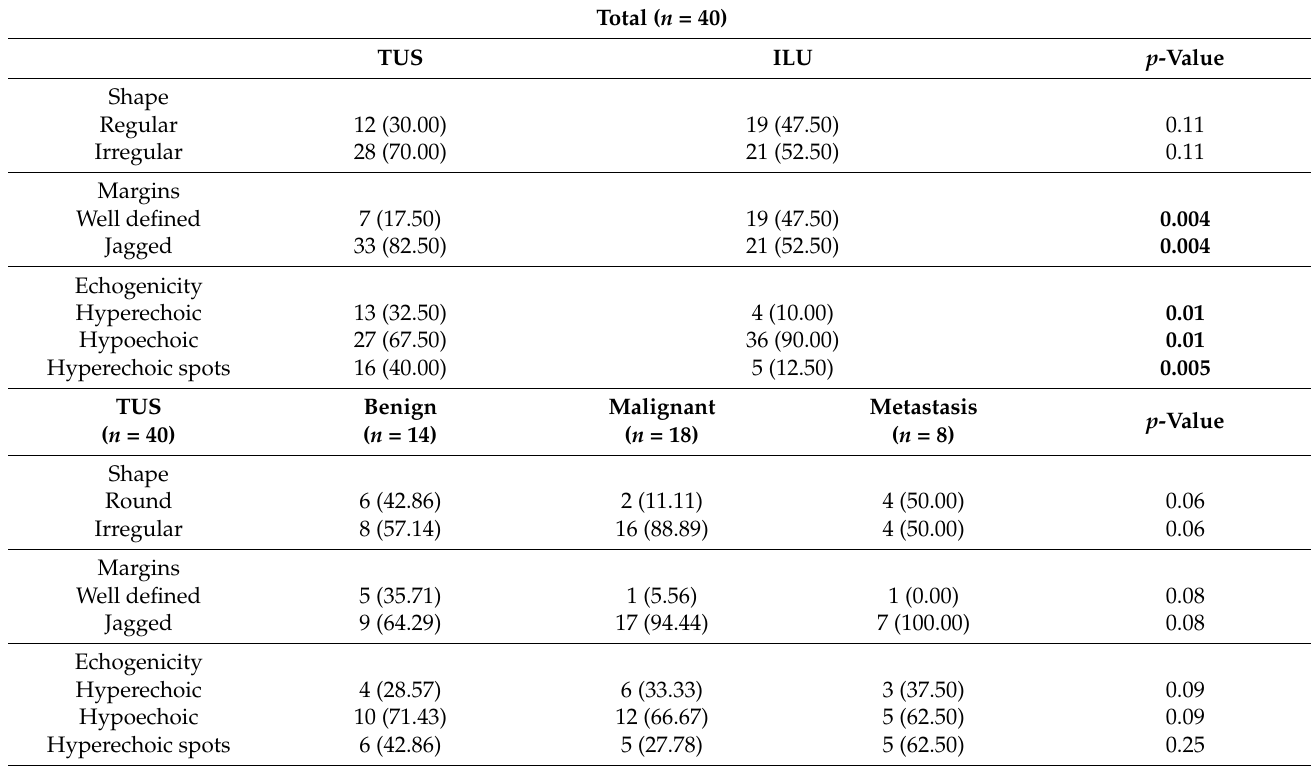
Table 4. Ultrasound characteristics of nodules examined using TUS compared to those recorded at ILU and their relationship to the pathologic nature of the